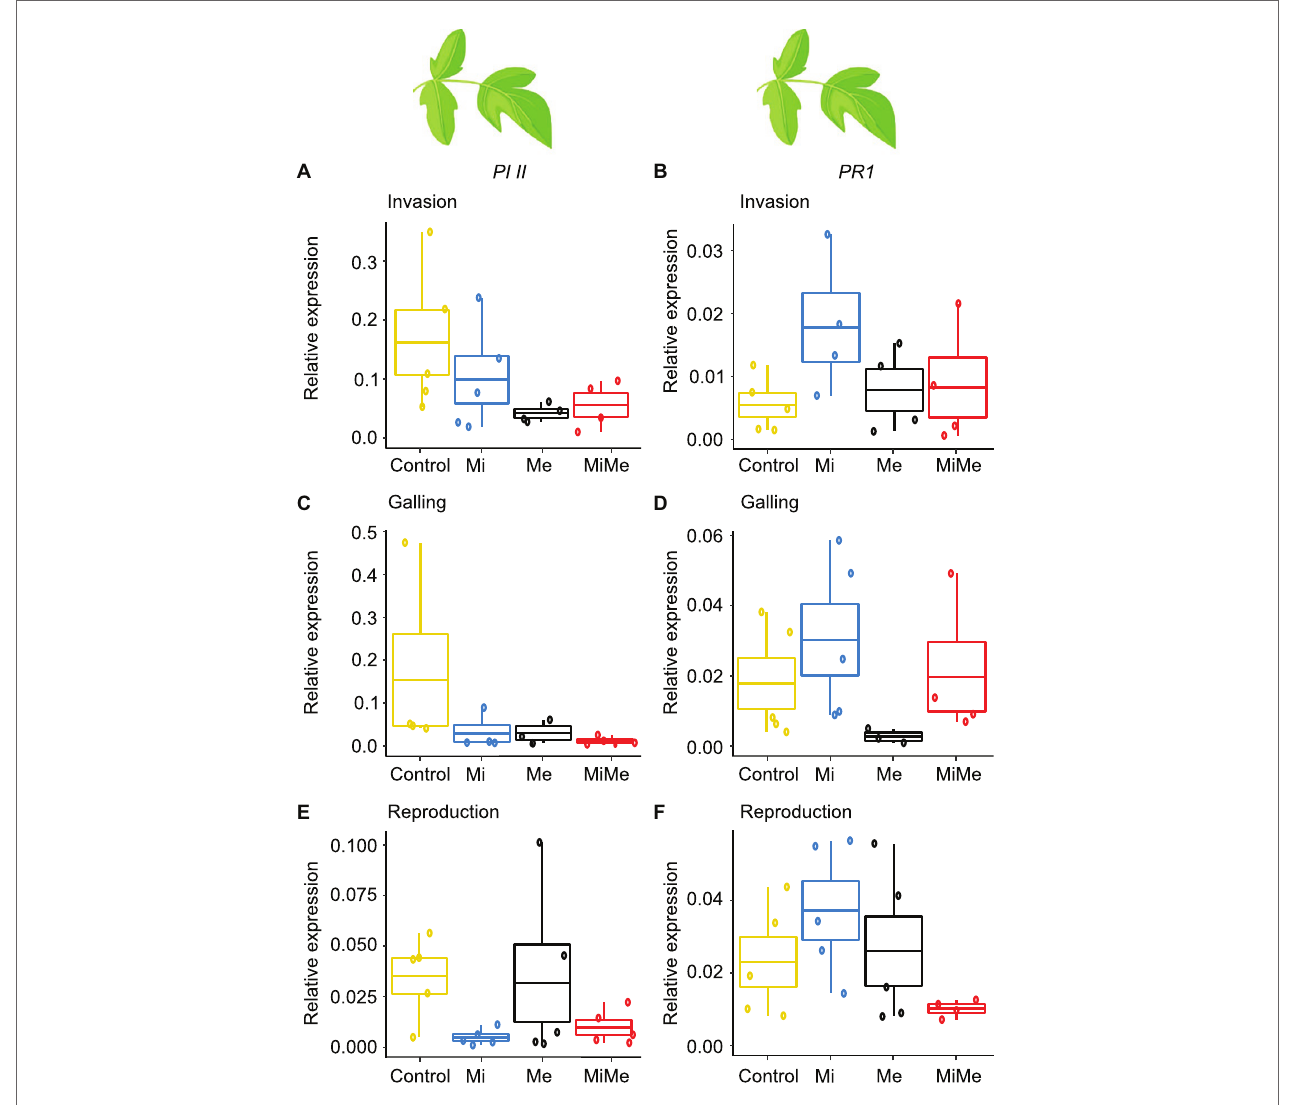
FIGURE 2 | Expression of the jasmonic acid (JA) marker gene Proteinase inhibitor II ( PI II ) and the salicylic acid (SA) marker gene Pathogenesis-related protein 1 (PR1) in tomato leaves upon aboveground and belowground herbivory. Relative expression of PI II and PR1 genes were analyzed in leaves of tomato plants infected belowground with Meloidogyne incognita (Mi), or infested aboveground with Macrosiphum euphorbiae (Me) or with both herbivores (MiMe). Control = plants without herbivores. Boxplots indicate mean (±SEM, n = 5) expression values of PI II (A,C,E) and PR1 (B,D,F) , measured at the nematodes’ invasion (A,B) , galling (C,D) , or reproduction (E,F)